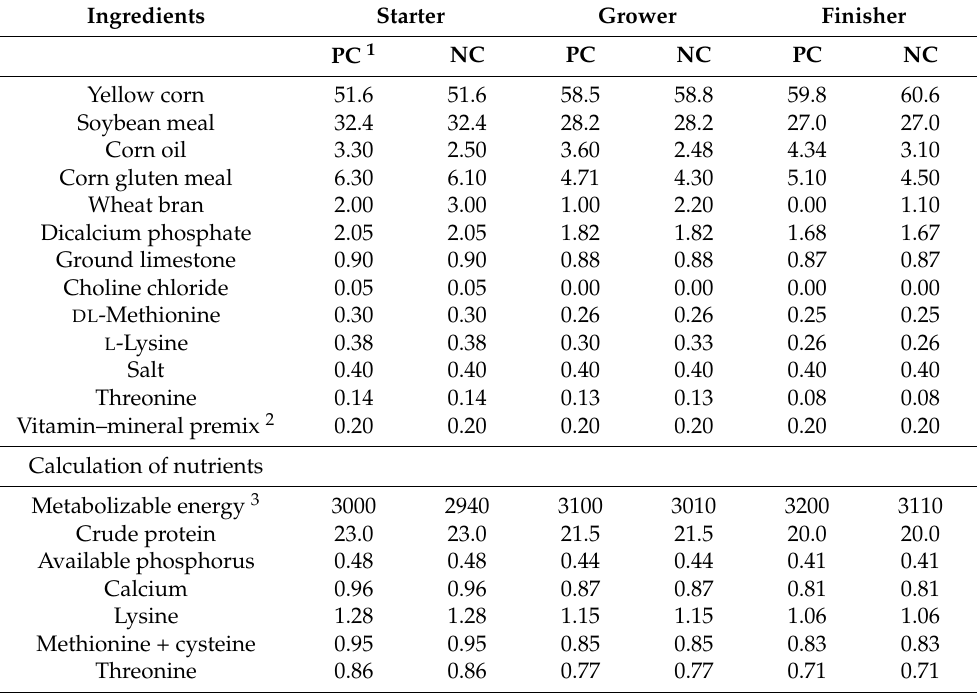
Table 1. Ingredients and nutrient contents of the experimental diets (%, as-fed